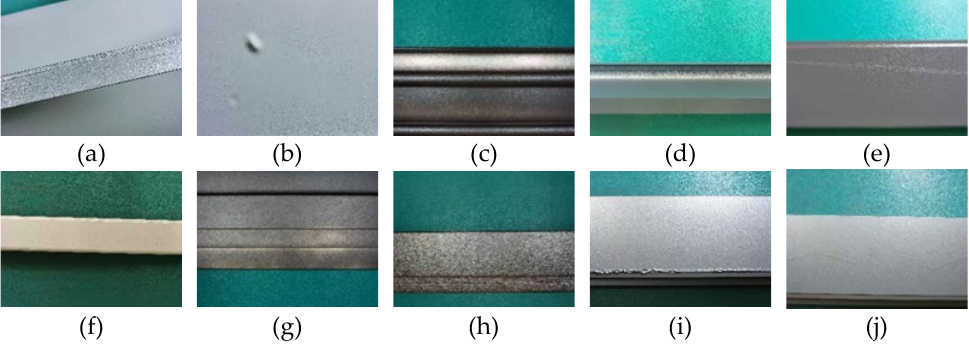
Figure 7. Aluminum profile surface defect images in ten categories: (a) concave line (cl); (b) dirty spot (ds); (c) exposed bottom (eb); (d) exposed corner bottom (eb); (e) graze (gra); (f) mixed color (mc); (g) non-conductive (nc); (h) orange peel(op); (i) paint bubble (pb); (j) spary paint flow (spf). Table 4. The division of training set, validation set, and testing set images.